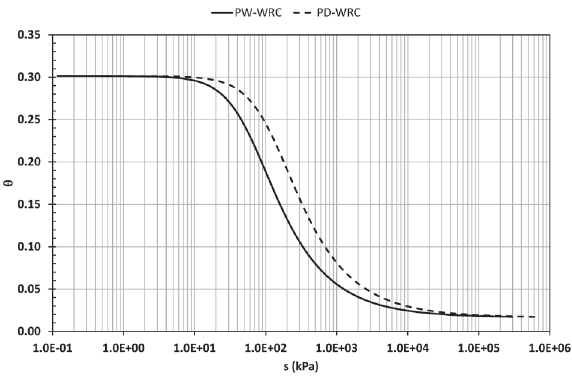
Figure 9: Water retention